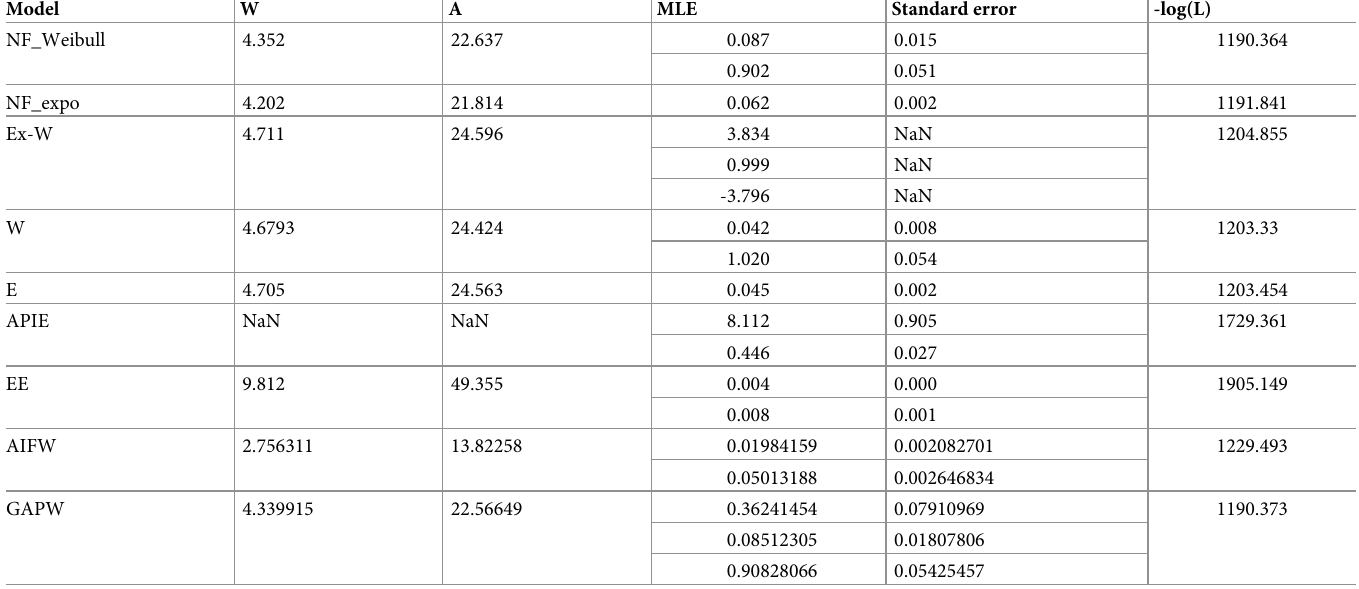
Table 4. MLE and standard errors for Covid-19 death rates data of Pakistan.